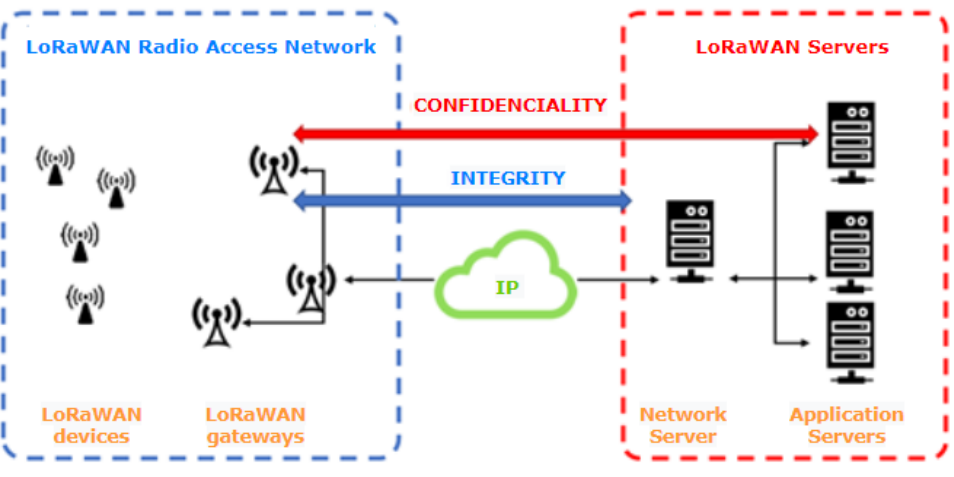
Figure 4. LoRaWAN architecture and